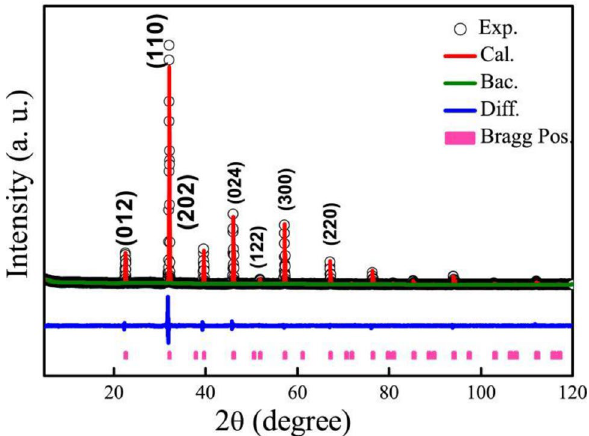
Figure 1. X-ray diffraction patterns for BSFCO are shown at the room temperature. The refined structure diffraction data are observed together with the experimental data points using Gasa refinement.